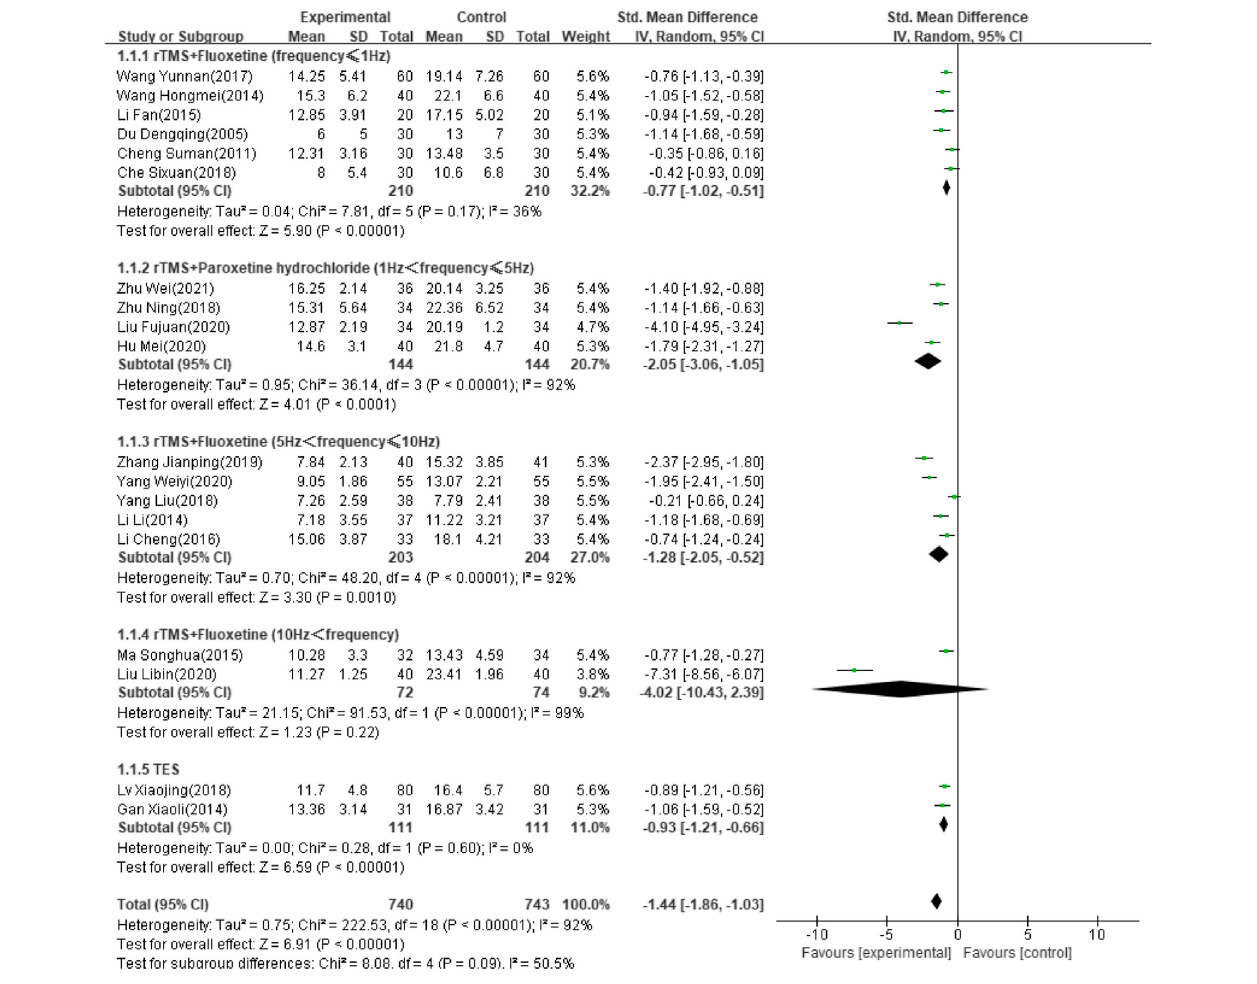
FIGURE 4 | Forest plot of HAMD